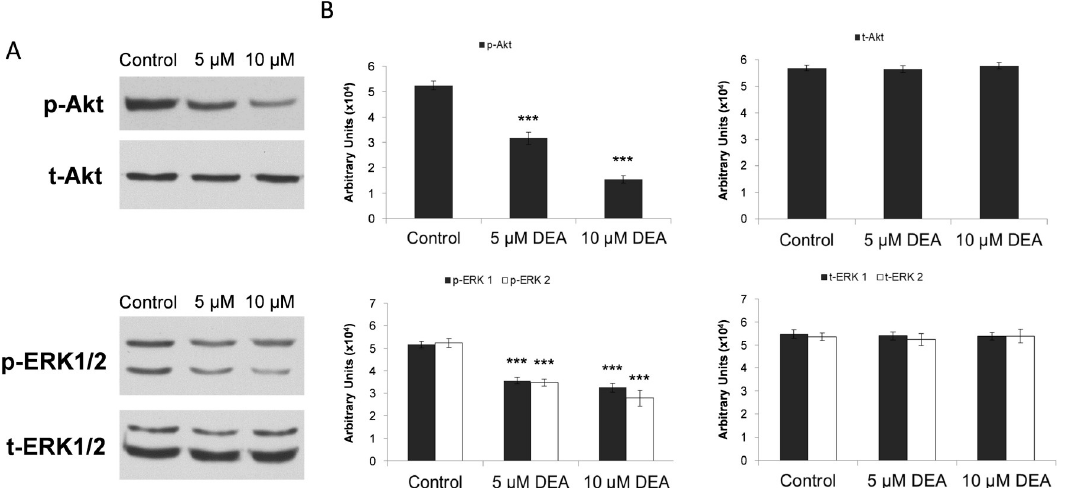
Fig 5. Effect of various DEA concentrations on the activation of cytoprotective signaling kinases in B16-F10 cells. Total cell extracts were analyzed by immunoblotting 24 hours after the DEA treatments. Activation of Akt and ERK1/2 as well as equal protein loading was confirmed by kinase specific primary antibodies: anti-Akt (t-Akt), anti-phospho-Akt (p-Akt), anti-ERK1/2 (t-ERK1/2) and, anti-phospho-ERK1/2 (p-ERK1/2). The figure shows the results of the immunoblots (A) and the densitometric analysis (B) of three independent experiments. Data are expressed as the mean ± SD, and presented as arbitrary unit. Data were analyzed using Mann-Whitney U test. ��� p � 0.001 compared to the control group.